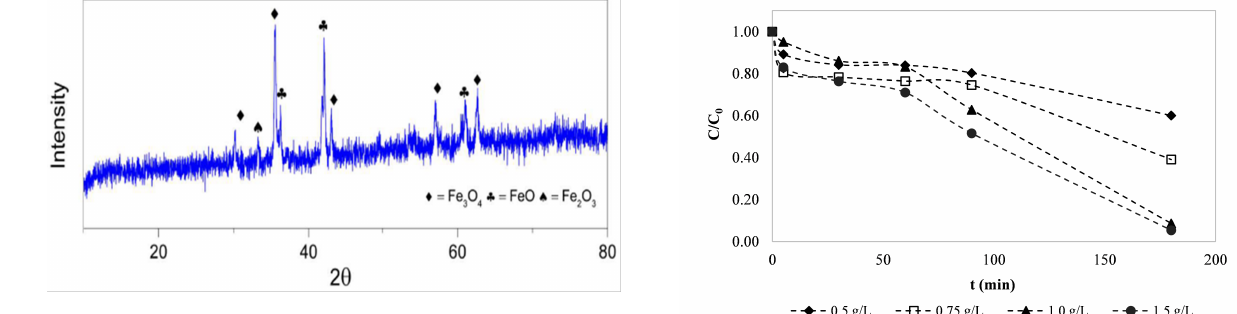
Fig. 2. XRD pattern of rebar flakes waste Spectrophotometry (AAS).